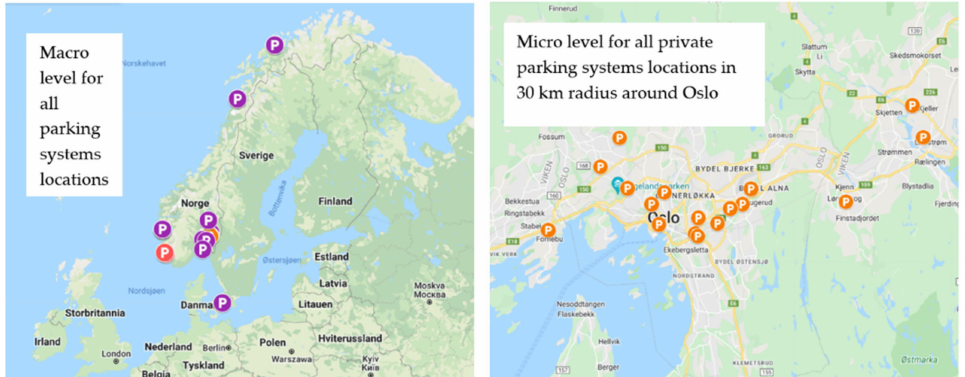
Figure 1. Map of overall company parking systems. Left: Macro-level for all parking systems locations. Right: Micro-level for all private parking systems in a radius of 30 km around